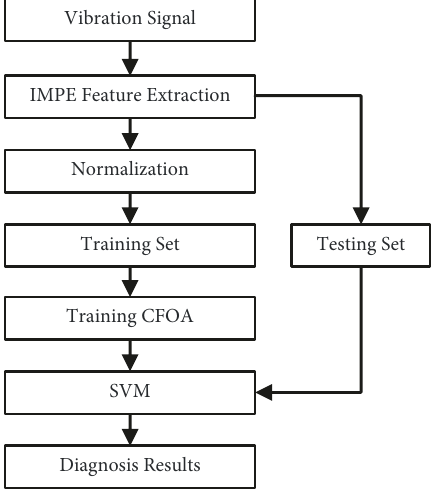
Figure 1: Overview of our